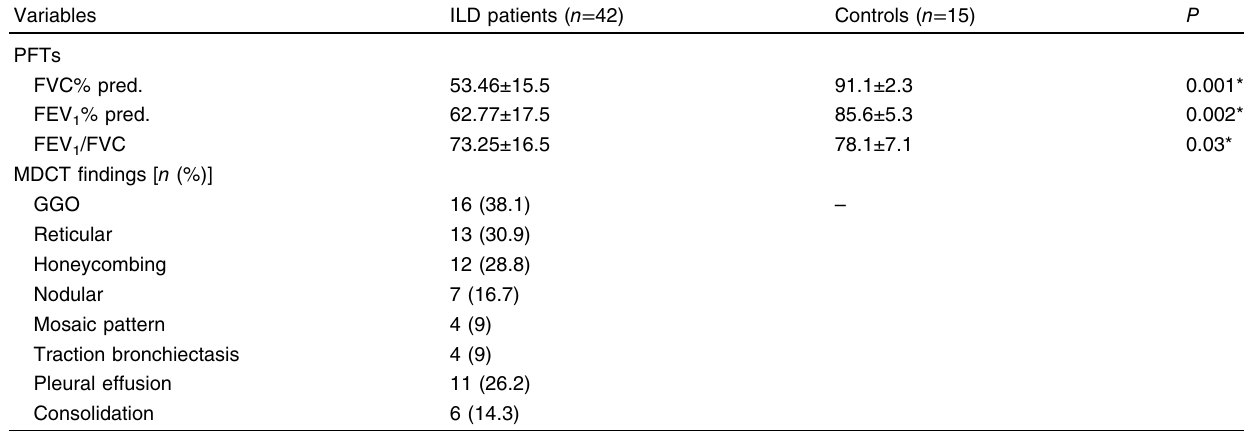
Table 2 PFTs and MDCT findings among the studied patients Variables ILD patients ( n = 42)